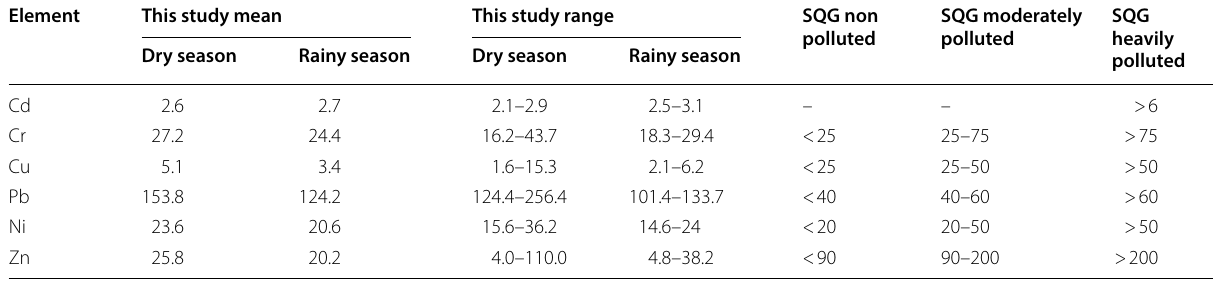
Table 5 Concentration of trace metals in sediments and its comparison with sediment quality guidelines (SQGs) in